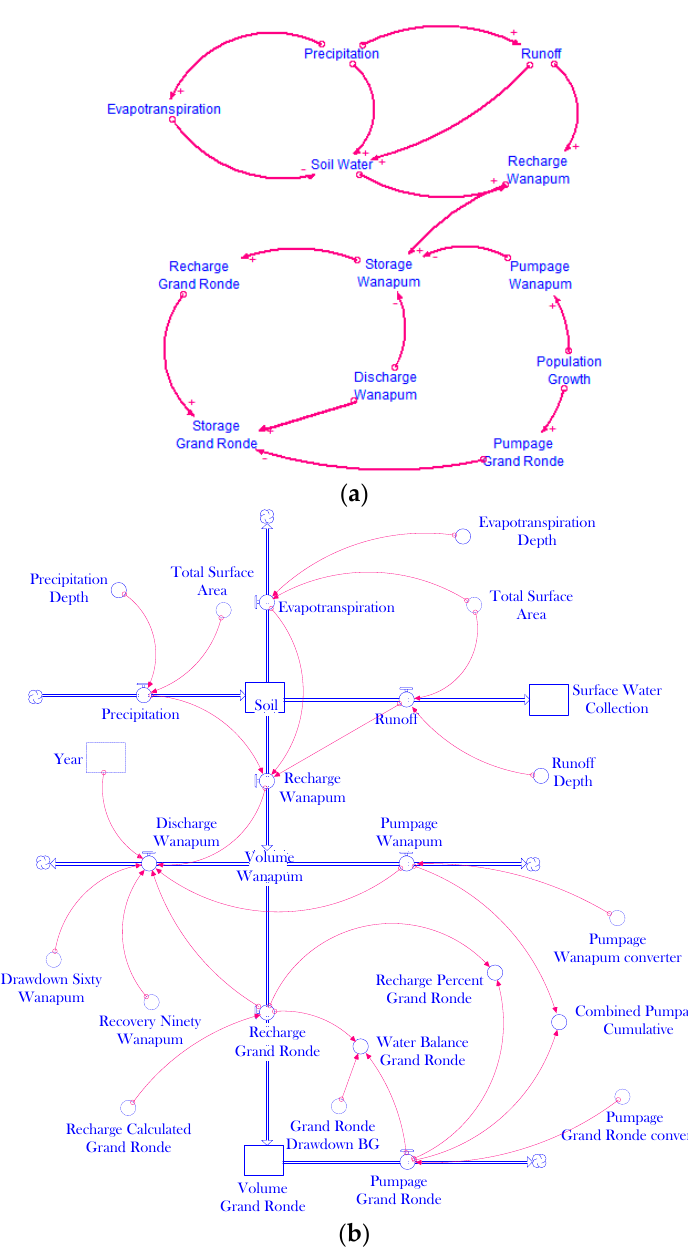
Figure 3. ( a ) Palouse Basin groundwater causal loop diagram in a simplest form; ( b ) Major components of System Dynamics model of the Palouse Basin watershed.